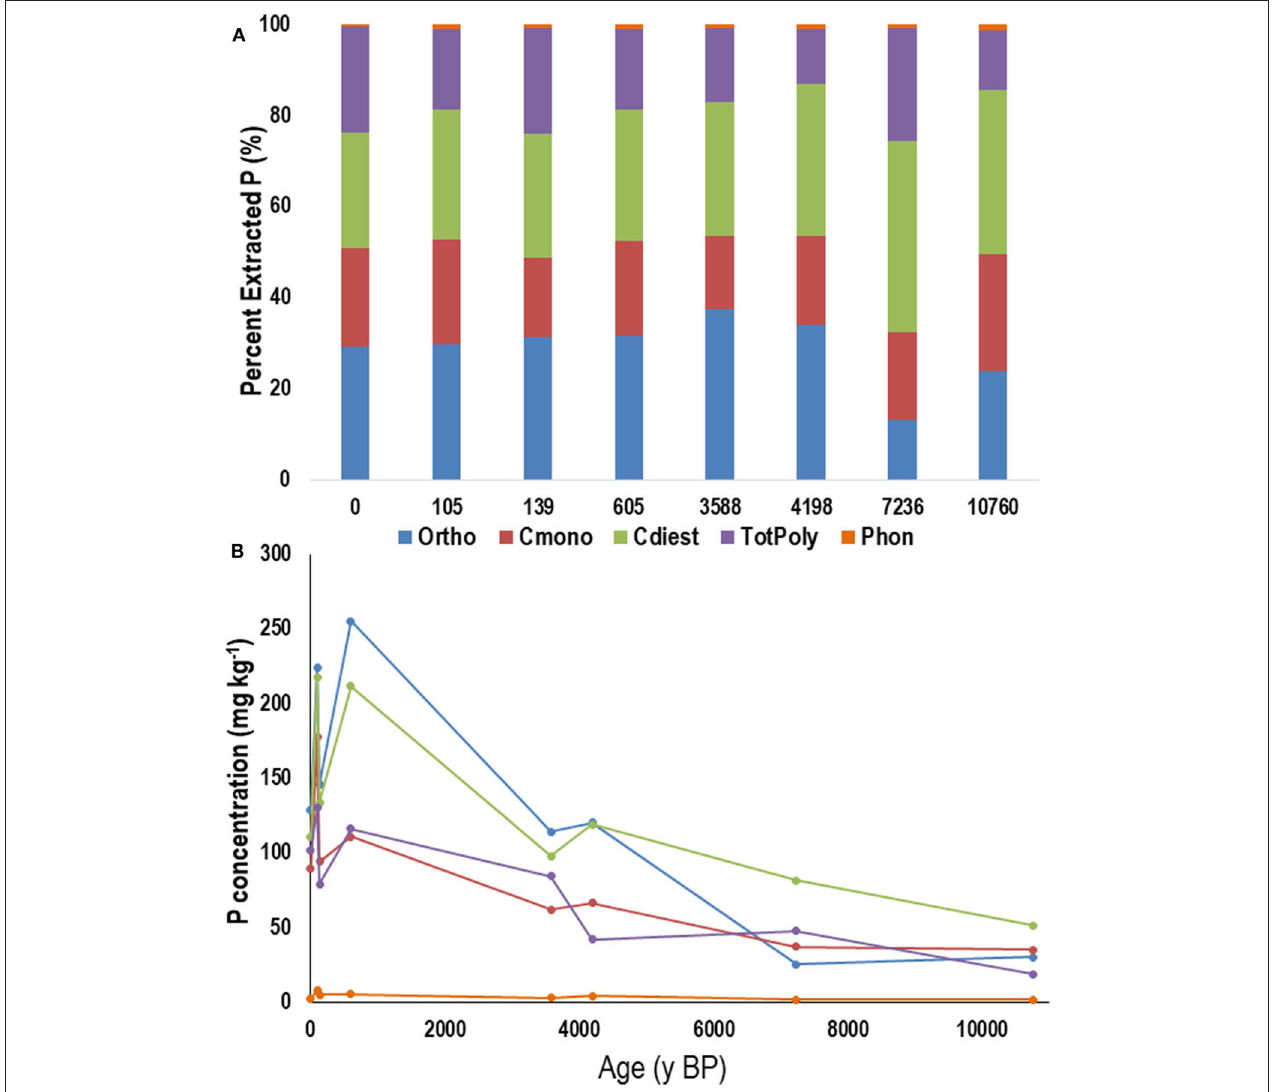
FIGURE 6 | Average proportion (A) and concentration (B) of phosphorus (P) in NaOH-EDTA extracts analyzed by P-NMR for the main groupings of P compounds in the litter (L) horizon from the Calvert Island BC chronosequence. Ortho, orthophosphate; Cmono, Cdi, orthophosphate monoesters and corrected for degradation during analysis; totPoly, total polyphosphates; Phon, phosphonates. Values are means; n =